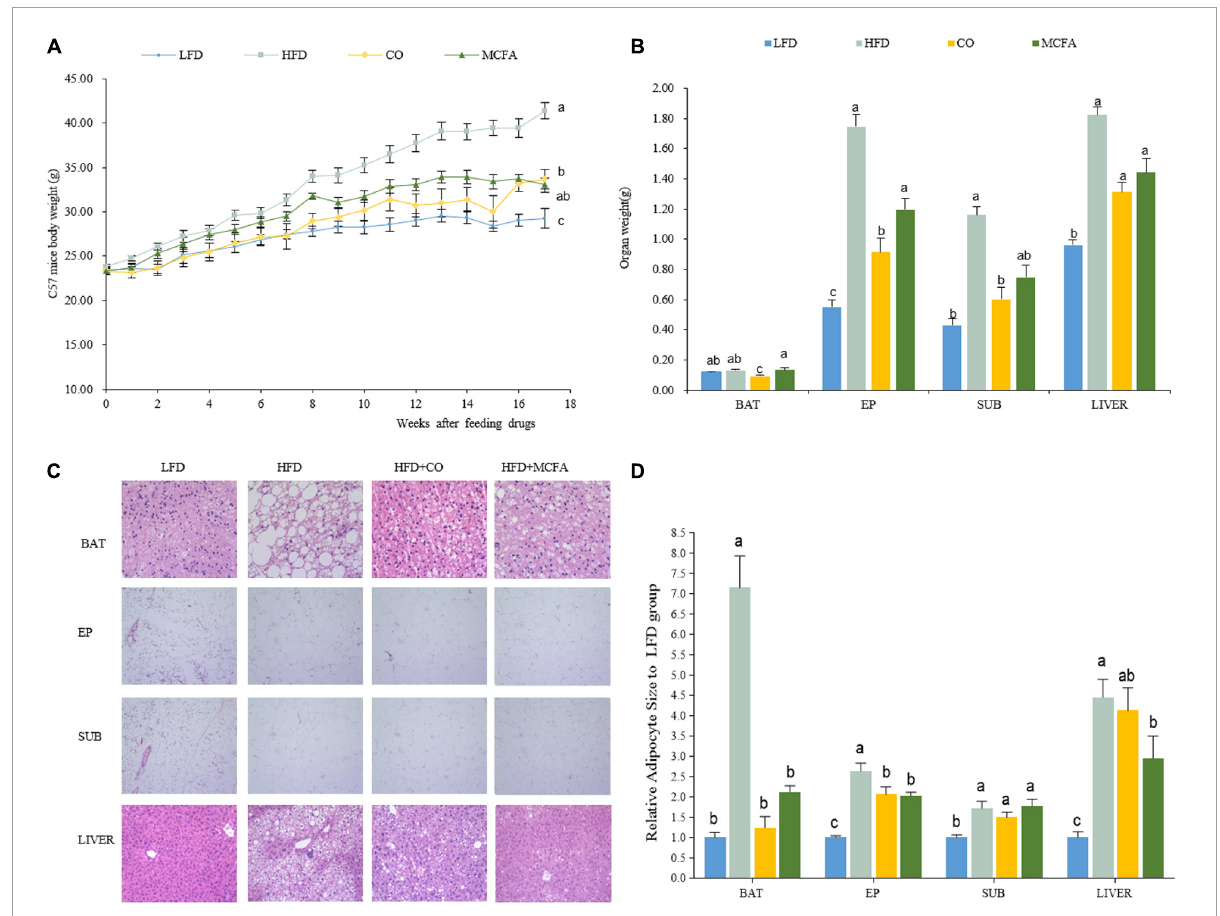
FIGURE1 CO and MCFA reduce body weight gain. (A) Weekly body weight ( n = 12). (B) The organ weights of the LFD, HFD, CO + HFD, and MCFA + HFD mice ( n = 12). (C) HE staining of BAT ( × 40), EP WAT ( × 10), SUB WAT ( × 10), and liver ( × 20) of the LFD mice, HFD mice, and HFD mice treated with either CO or MCFA. (D) Relative adipocyte size to LFD group. Values represent means ± SEM. Mean values with different letters are significantly different ( P <